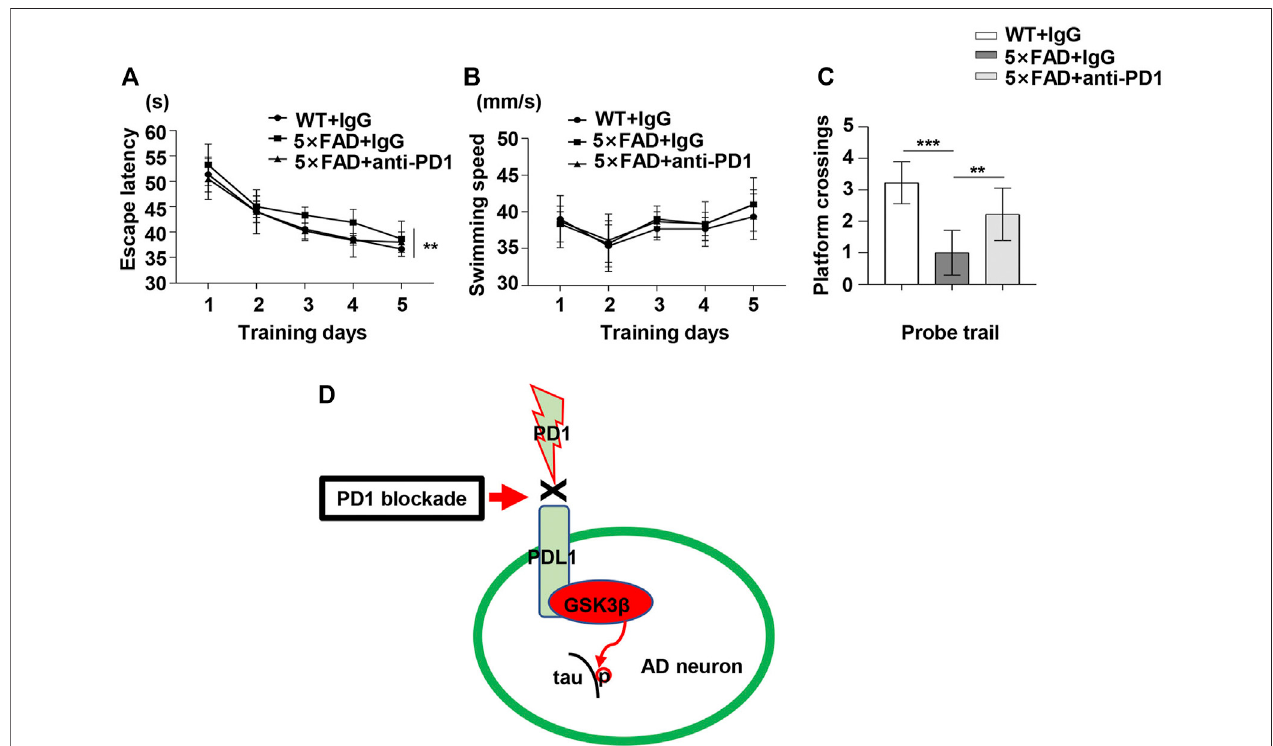
FIGURE 6 | PD1 blockade improved memory in 5 × FAD mice. Male 5 × FAD mice (average age 9 – 10 months, n (cid:2) 9/group) were administered either anti-PD1 monoclonal antibody or control hamster IgG. MWM was performed 1 month later. (A – C) PD1 blockade signi fi cantly improved behavioral performance compared with hamster IgG treatment. (A) Escape latency and (B) swimming speed during the training trial (** p < 0.01, two-way ANOVA followed by Dunnett ’ s post-hoc test). (C) Platform crossing during the probe trial (*** p < 0.001, ** p < 0.01, one-way ANOVA followed by Dunnett ’ s post-hoc test). (D) The proposed role of the PD1/PDL1 axis in the regulation of GSK3 β activity issummarized in aschematic diagram. Under AD conditions, the PD1-PDL1 pathway is activated, leading to increased activity of the effector GSK3 β . PD1 de fi ciency or PD1 antibody blocks the PD1/PDL1 axis, ultimately decreases GSK3 β activity and ameliorates tau hyperphosphorylation in the AD